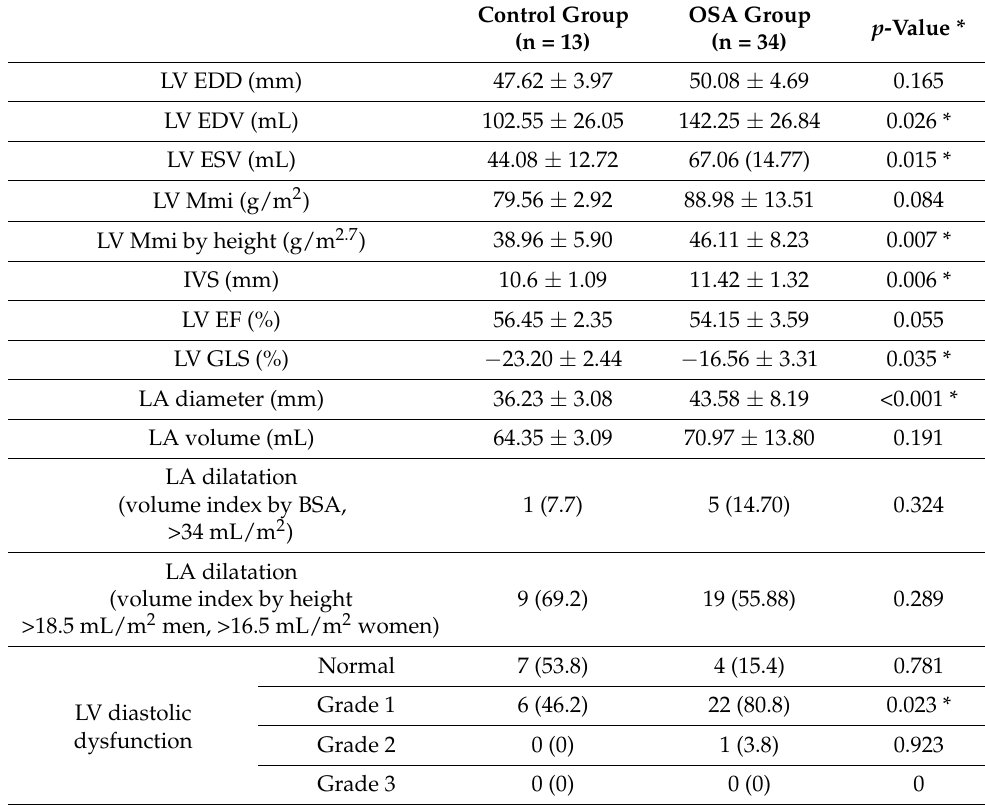
Table 3. Echocardiographic parameters of control and OSA group